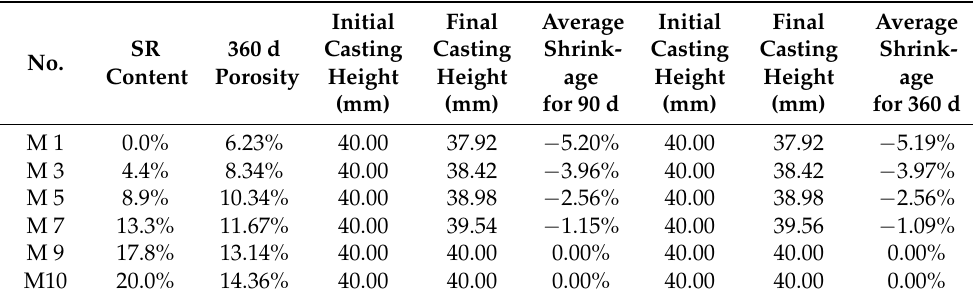
Table 5. The porosity and shrinkage of the SR–FFA–GEO mortars with different SR contents cured for 90 and 360 d at room